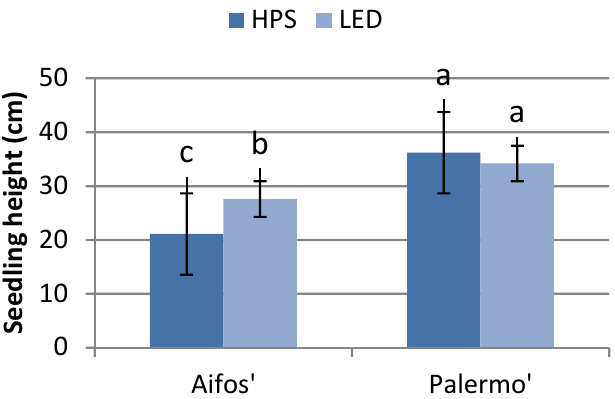
Figure 2. Effects of supplementary lighting with HPS and LED lamps on seedling height, depending on the cultivar. The mean values marked with the same letters do not differ significantly according to the Tukey HSD test at α = 0.05. The bars represent means ±SE.